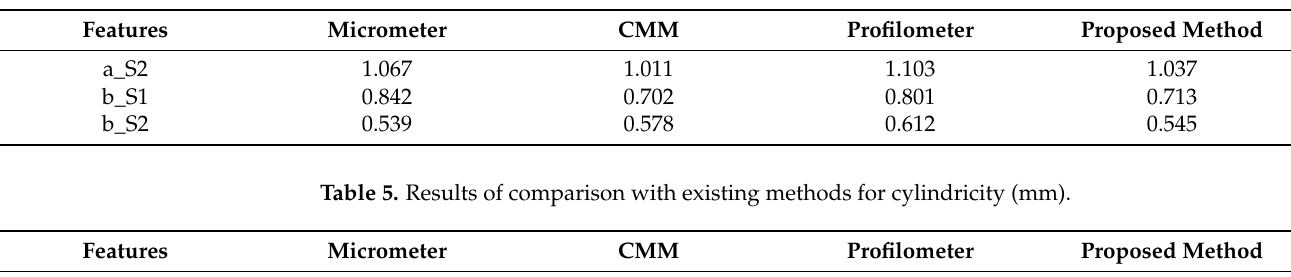
Table 4. Results of comparison with existing methods for flatness (mm).